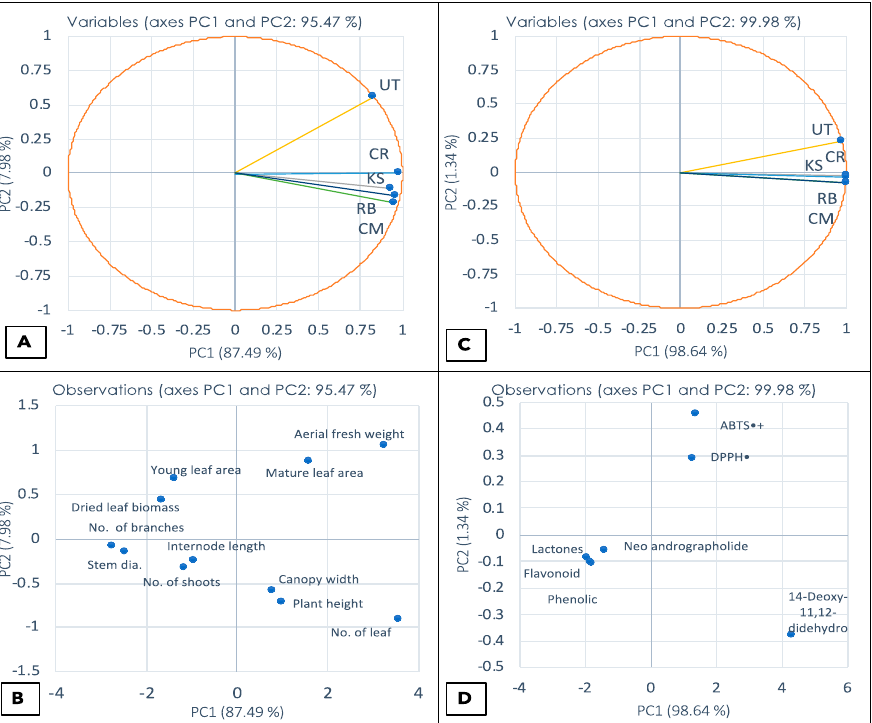
Figure 2. Principal Component Analysis (PCA) of physical characteristics of Andrographis paniculata between sample variables ( A ) and observations ( B ) and PCA of general chemical analyses between sample variables ( C ) and observations ( D ). The sample accessions were taken from KS = Kamphaeng Saen, UT = Udon Thani, CR = Chiang Rai, CM = Chiang Mai, RB = Ratchaburi.